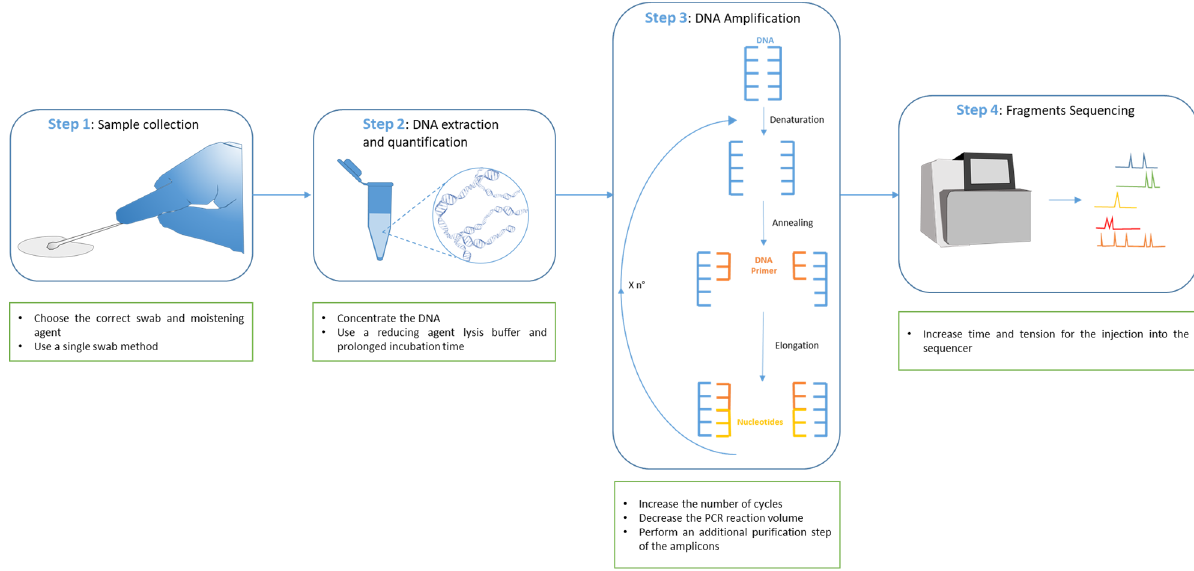
Figure 1. DNA analysis workflow and improvement for low template DNA. In sample collection, the correct swab should be chosen, and, in particular, collection through a single swab should be performed on non-porous surfaces; the use of tape lifting is a preferred option for porous surfaces. Moreover, in this step, the moistening agent is also of fundamental importance to improve the final results (Step 1). Other possible solutions to improve the DNA analysis of low template DNA consist of the concentration of the DNA after its extraction or in the use of reducing agent lysis buffer with a prolonged time of incubation to increase, in both cases, the concentration of the final extracted DNA in the reaction volume (Step 2). The following step of DNA amplification may be modified in different ways to improve the DNA analysis in the case of low-template DNA. It is possible to increase the number of PCR cycles, decrease the PCR reaction volume to further concentrate the amount of DNA, or perform an additional purification step of the amplicons (Step 3). Eventually, it is possible to also intervene in the last step of fragments sequencing by increasing the time and the tension for the injection of the DNA fragments into the sequencer (Step 4).